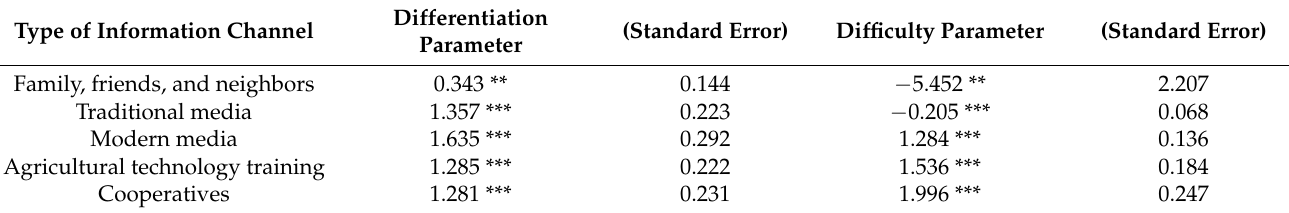
Table 3. Estimation results of differentiation and difficulty parameters.